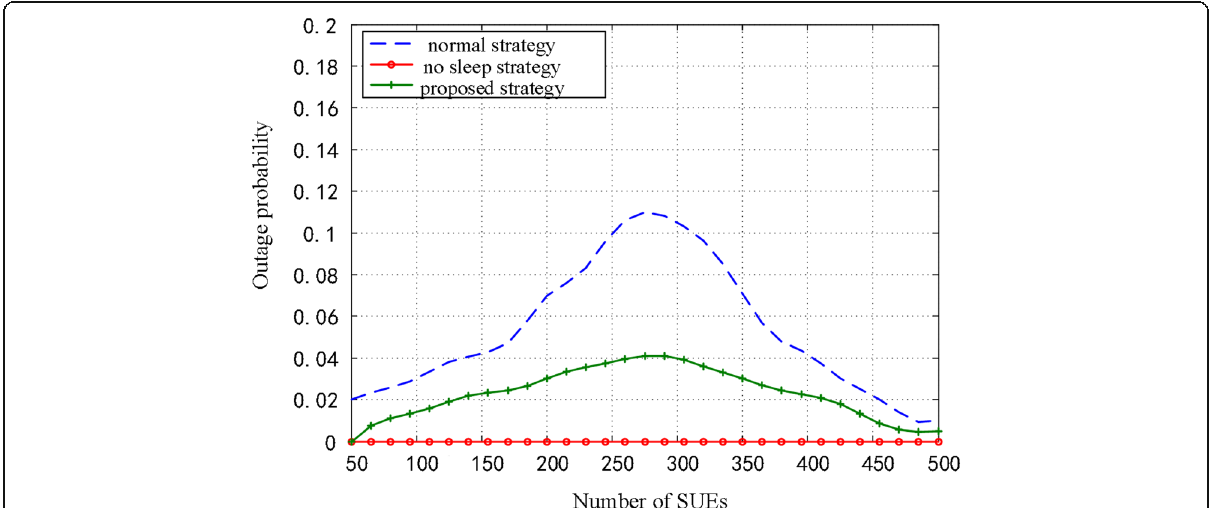
Fig. 6 Outage probability of the system. The outage probability will be zero if there is no sleep mechanism in the system as shown in Fig. 6. It is possible that some small BSs enter the sleeping mode when the system takes the sleep strategy. It is shown that the outage probability increases firstly because the UEs ’ growth rate is larger than the activation rate. And the outage probability will gradually decline as the increasing number of activated small BSs. Therefore, the outage probability firstly increases and then decreases with the user ’ s number. In the proposed strategy, we take the sleep mechanism in each cluster to improve the efficiency of sleep and activation. Hence, we can see the decline of outage probability in the system as a